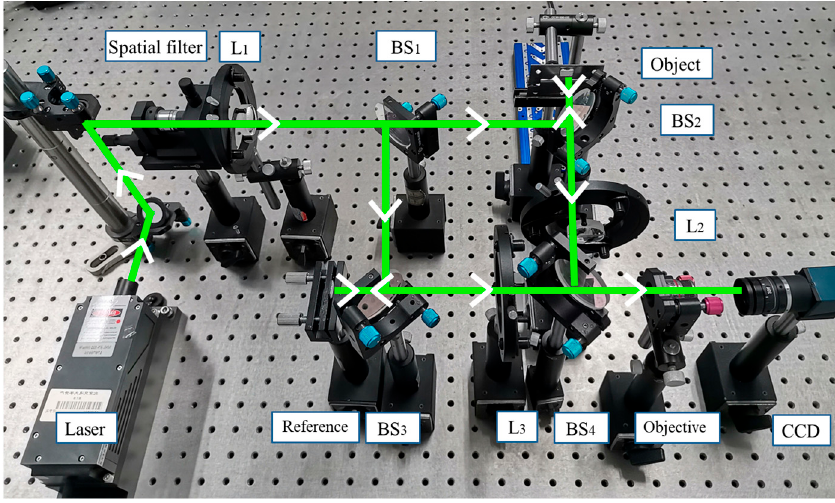
Figure 6. The measurement system diagram with the introduction of doublet lens group.